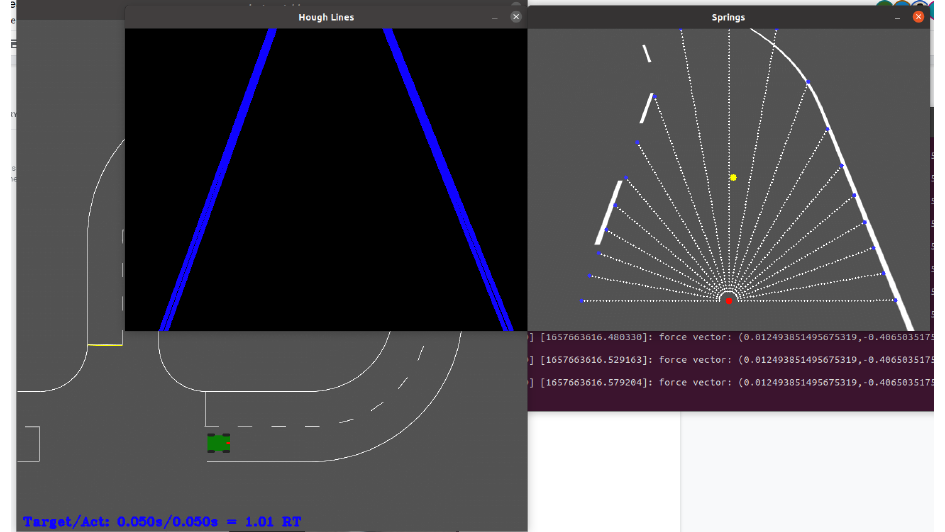
Figure 18. The above image shows the working of the algorithm in simulation. The blue lines indicate the Hough lines and the yellow point indicates the center of the lane. The rays are extended until they touch the Hough lines on either